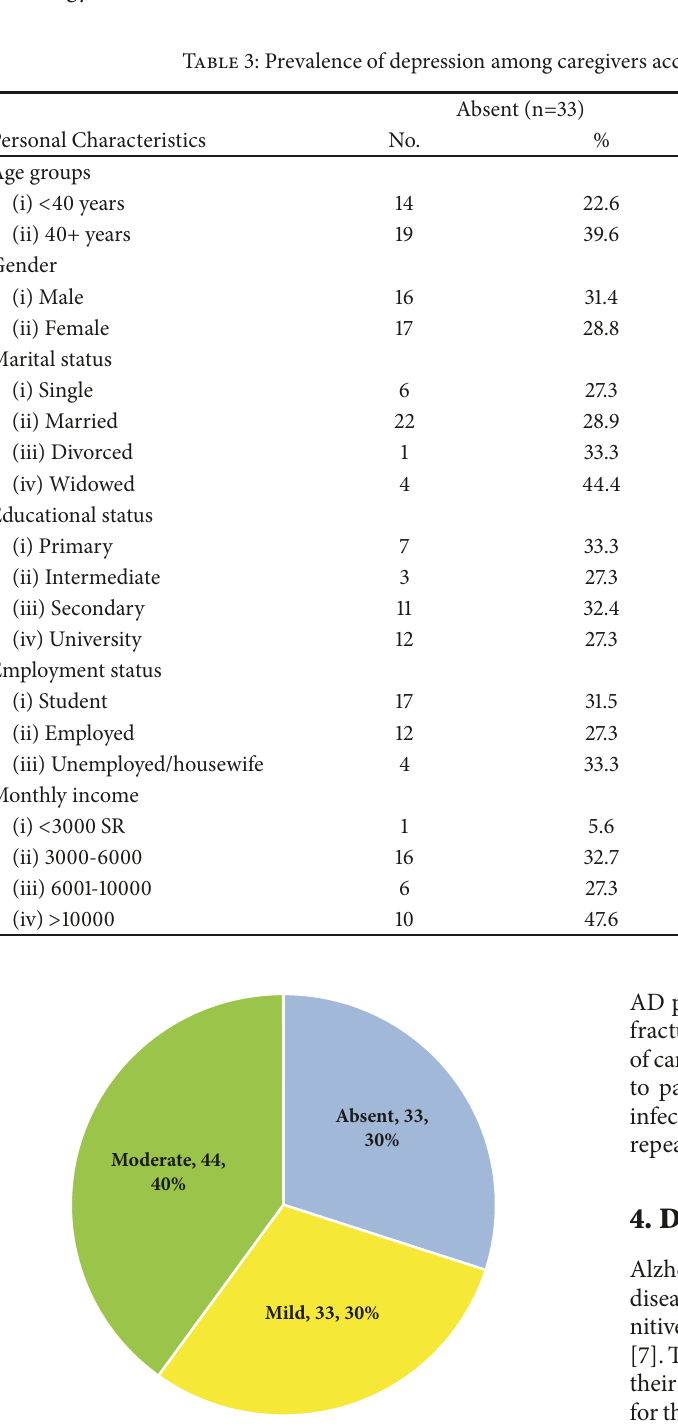
Figure 1: Grades of depression symptoms among caregivers of AD